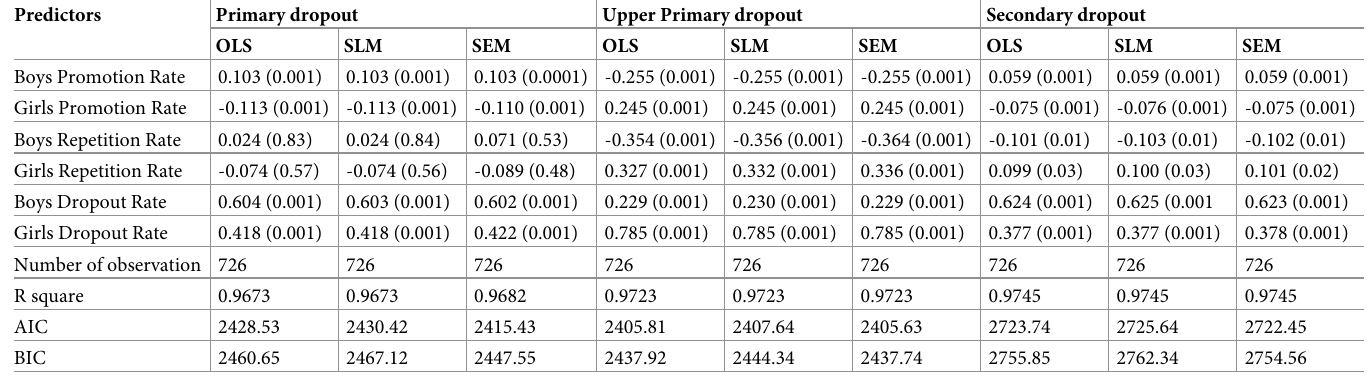
Table 4. OLS, SLM and SEM estimation of school dropout,